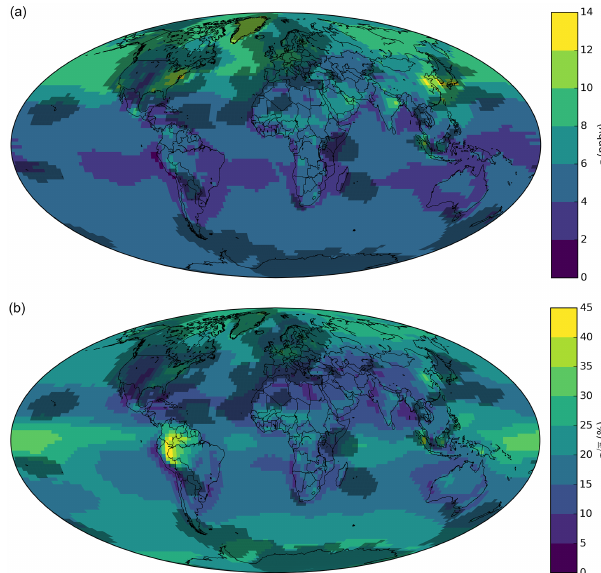
Figure 6. Map of the (a) absolute and (b) fractional standard de- viation in annual mean surface ozone between ACCMIP models, following Young et al. (2013). Shaded regions are areas that are covered by the footprints of ozone sites; light regions do not have ozone